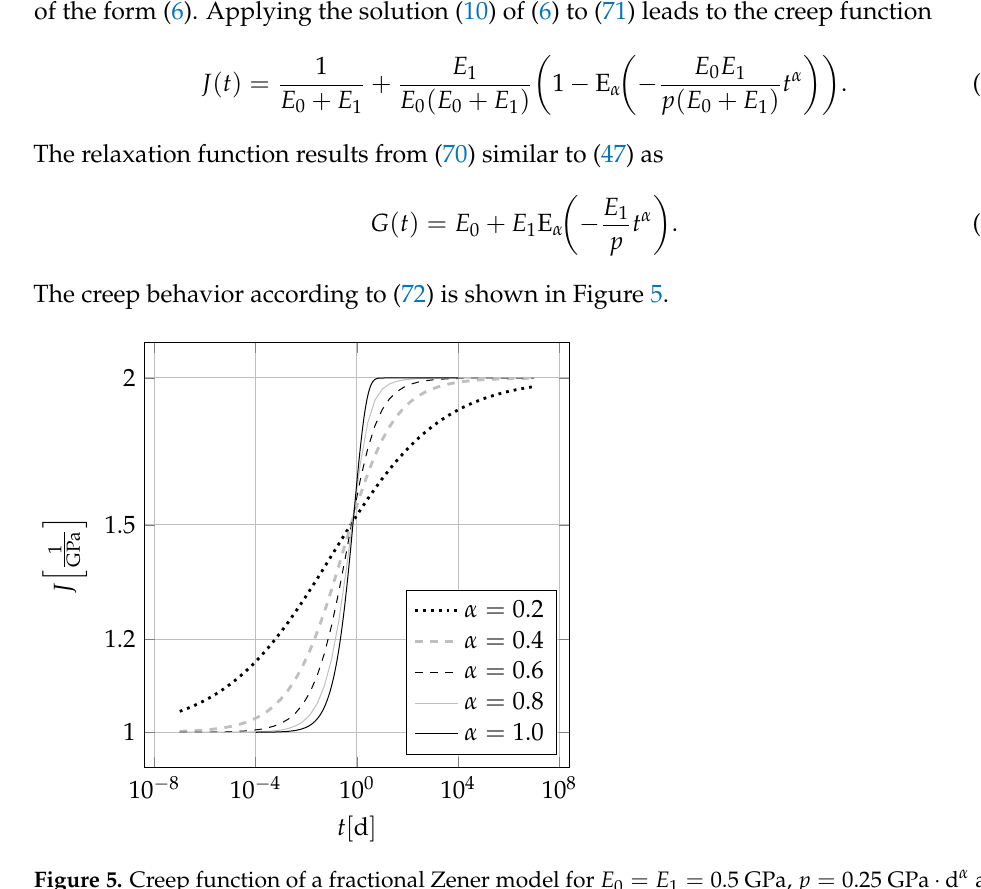
Figure 5. Creep function of a fractional Zener model for E 0 = E 1 = 0.5 GPa, p = 0.25 GPa ( 0,1 ) various values of α ∈